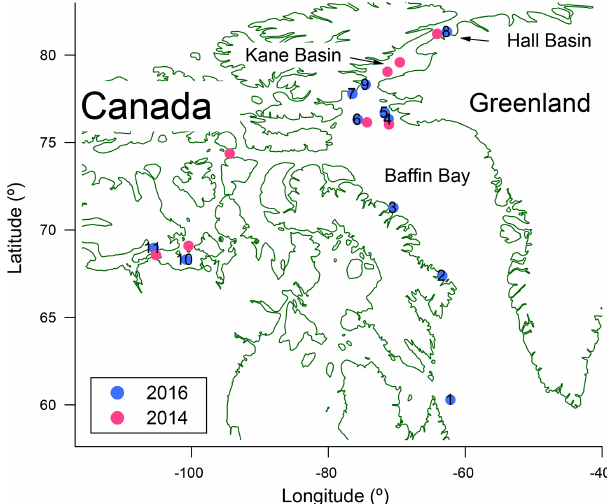
Figure 1. Map showing locations of microlayer and bulk seawater sampling in 2014 (pink) and 2016 (light blue, with specific station numbers in